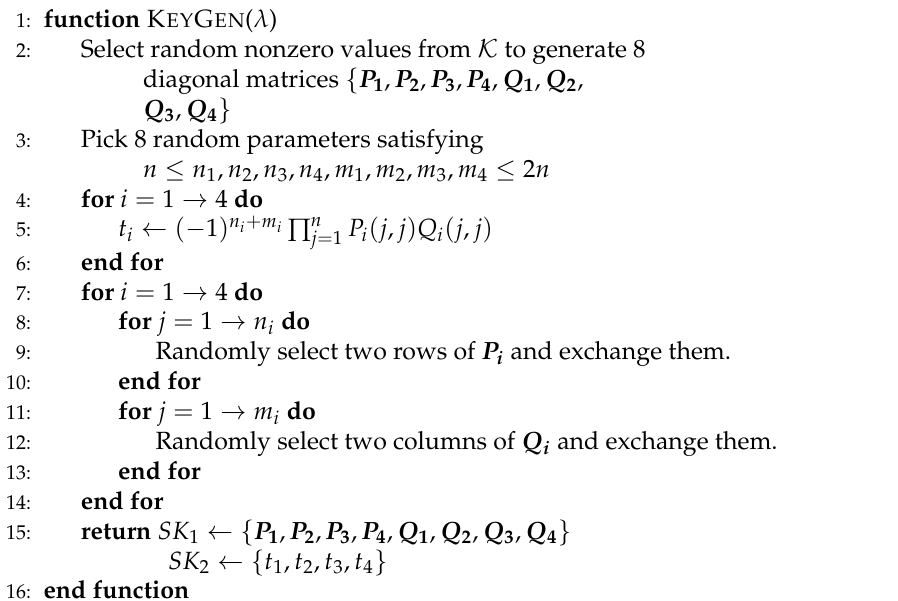
Algorithm 1 Procedure of Secret Key